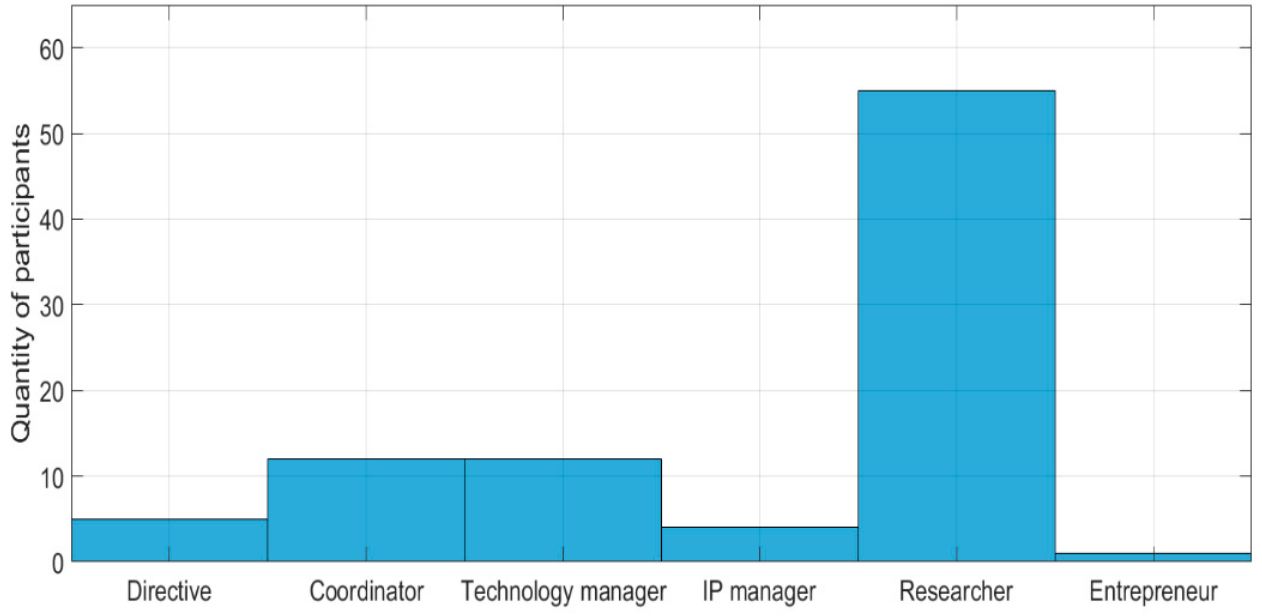
Figure 5. Histogram for the survey participants by taking into account the affiliation role in the universities.